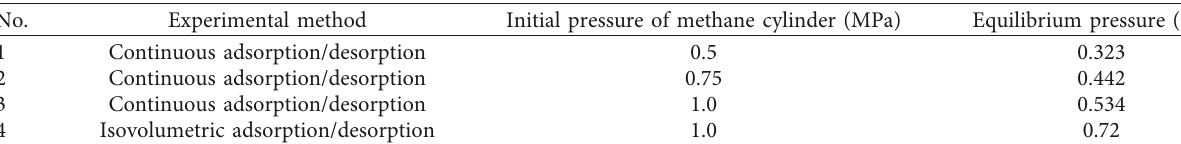
Figure 1: Test system for measuring the resistivity of coal sample. Table 2: Experimental program.